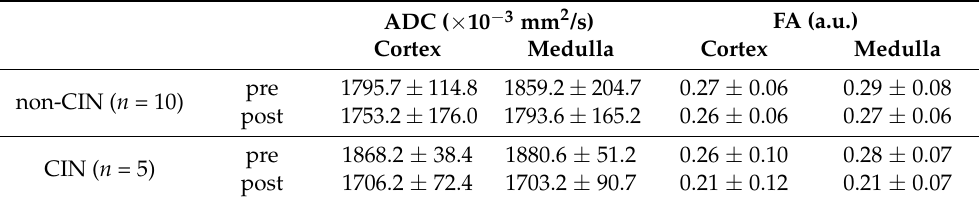
Table 2. Mean cortical and medullar diffusion values (apparent diffusion coefficient (ADC), fractional anisotropy (FA)), and standard deviation pre- and post-administration of iodine-containing XCM are displayed. A significant drop of cortical and medullar ADC and FA values was identified for the contrast-induced nephropathy (CIN) group ( p <